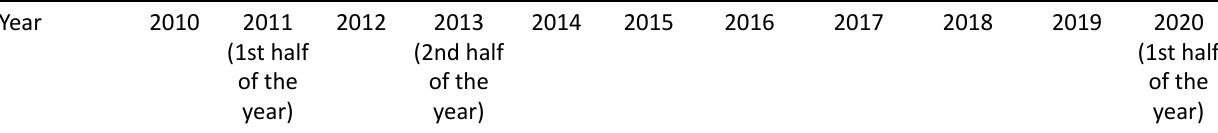
Source: Central Statistical Office (2019).